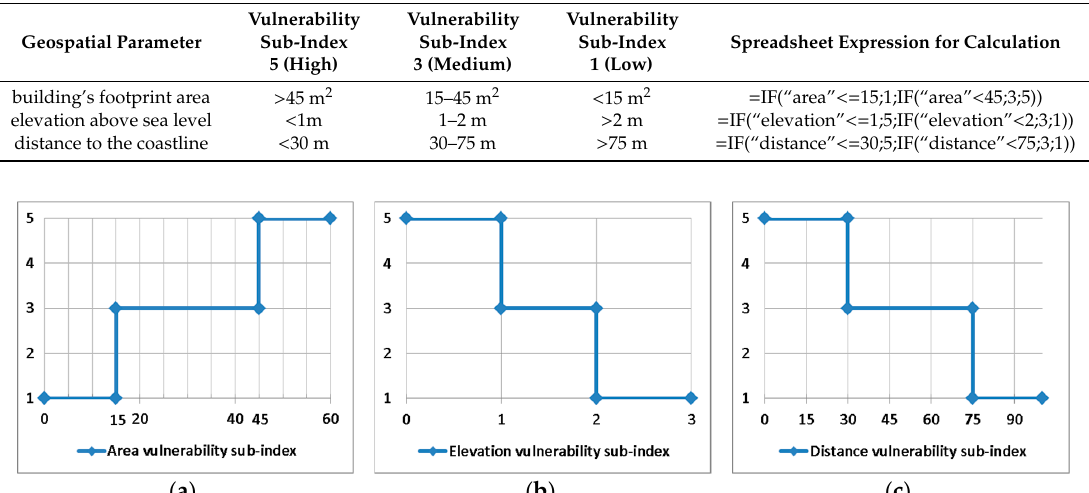
Figure 3. Graphs showing the crisp rankings of the key geospatial parameters—vulnerability sub-indices: ( a ) for the building’s footprint area; ( b ) for elevation above the sea level; and ( c ) for distance to coastline.